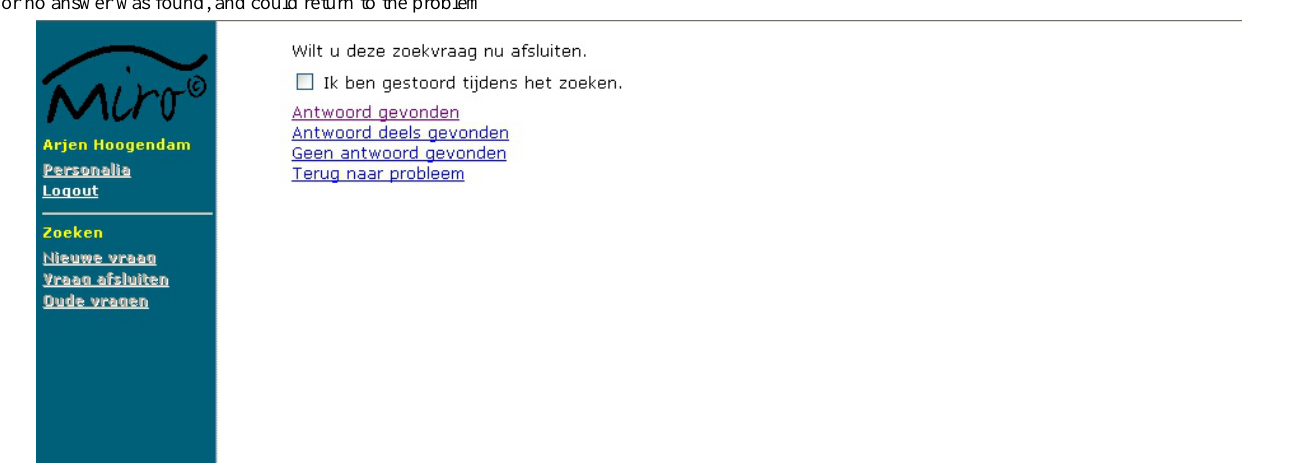
Figure 5. Screenshot of the page where details regarding the search could be provided